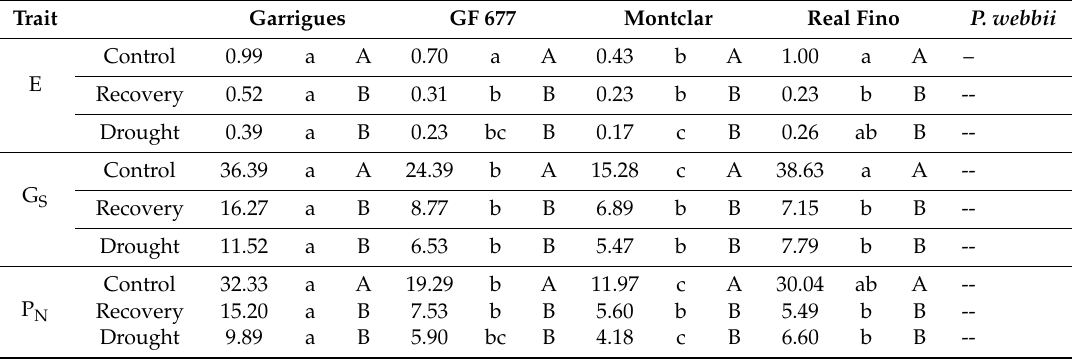
Table 2. Mean values for the traits studied. Means with at least one identical lowercase letter within a column of one trait are not significantly di ff erent from each other cultivars. Means with at least one identical uppercase letter within a row are not significantly di ff erent from each other between treatment ( p < 0.05). E: transpiration rate; G S : stomatal conductance; P N : net photosynthesis